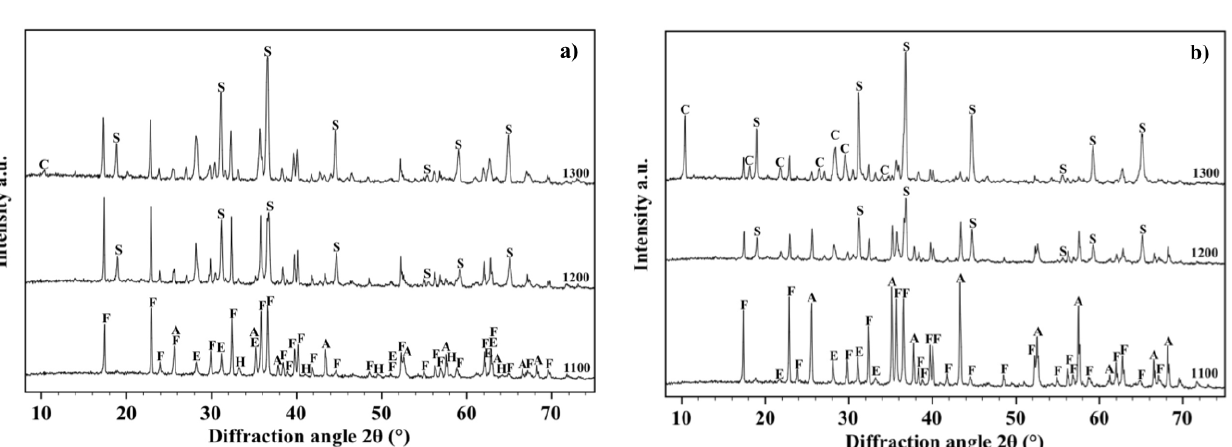
Figure 9. X-ray diffraction patterns between 10° and 70° acquired on the free surface of samples OA20 ( a ) and OA40 ( b ) fired at 1100, 1200 and 1300 °C. Phases are identified by the following symbols: (E) = enstatite, (F) = forsterite, (H) = hematite, (A) = alumina, (S) = spinel and (C) =